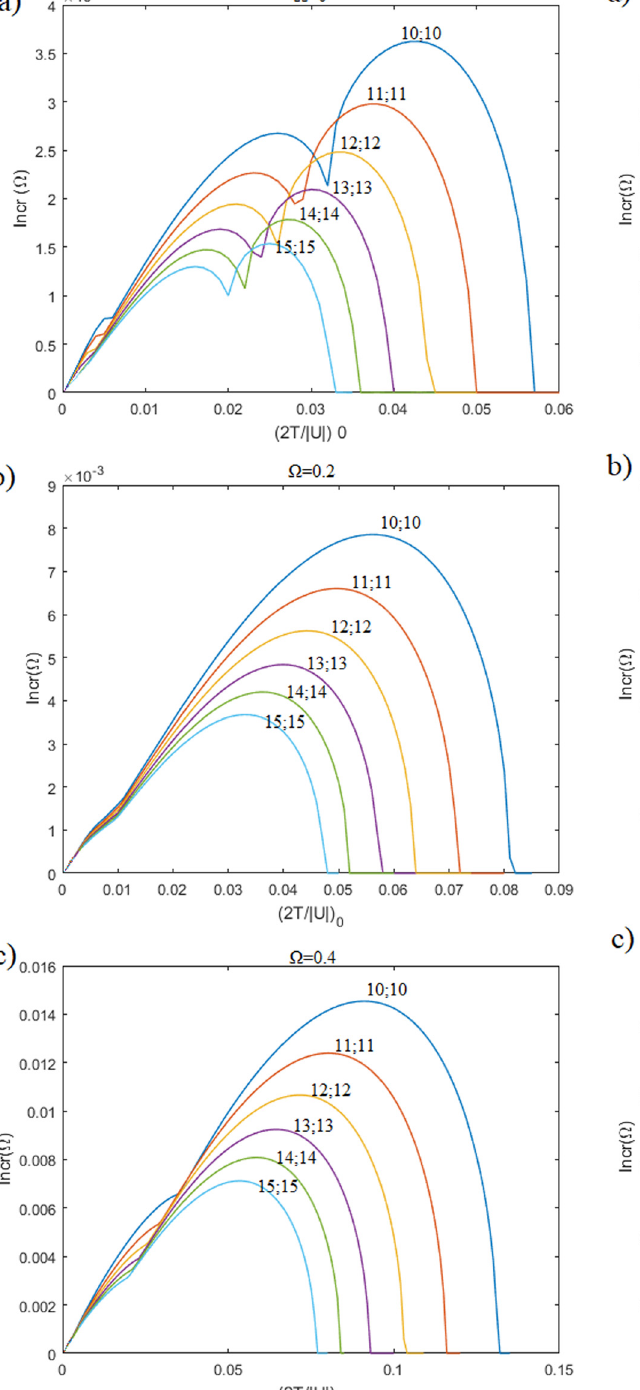
Figure 7: ( a to c ) Comparison of the increments of instabilities of all small - scale oscillation modes for di ff erent values of the rotation parameter.